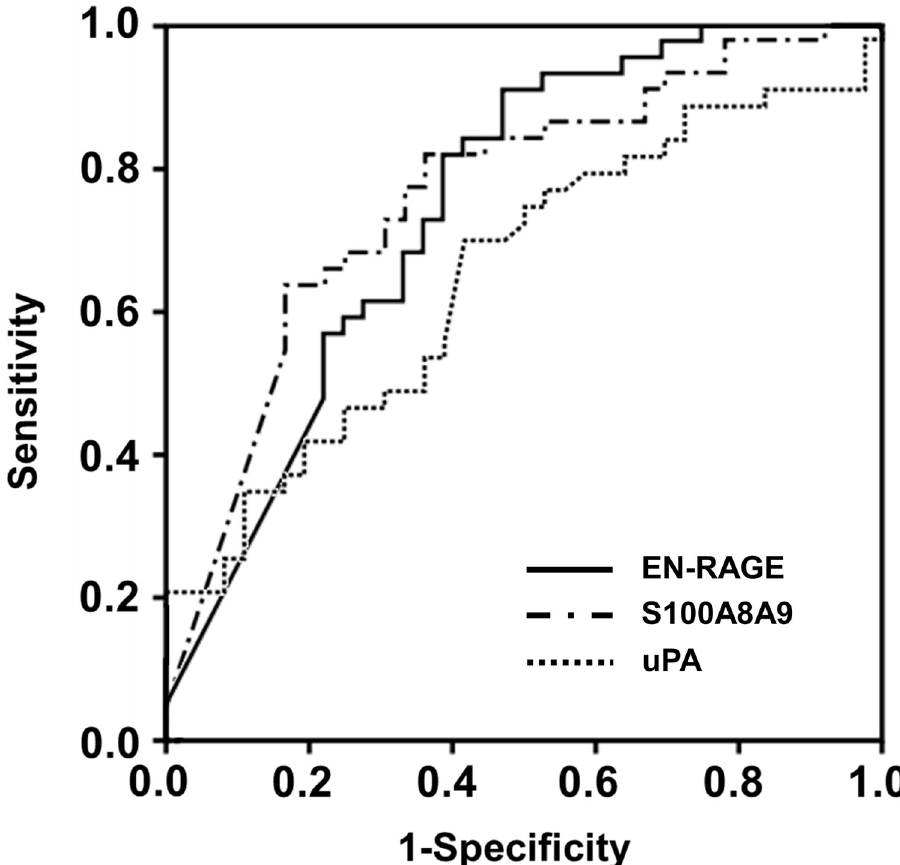
Fig 2. Receiver operating characteristic (ROC) curves of amniotic fluid (AF) EN-RAGE, S100A8/A9, and uPA at predicting spontaneous preterm birth (SPTB) at < 32 weeks of gestation (AF EN-RAGE: area under the curve [AUC] = 0.744, SE = 0.057; AF S100A8/A9: AUC = 0.763, SE = 0.054; and AF uPA: AUC = 0.649, SE = 0.062). Differences among the AUCs of AF EN-RAGE, S100A8/A9, and uPA were not significant (all variables: P = 0.09–0.66). EN-RAGE, extracellular newly identified receptor for advanced glycation end products binding protein; S100A8/A9, S100 calcium binding protein A8/A9 complex; uPA, urokinase-type plasminogen activator.